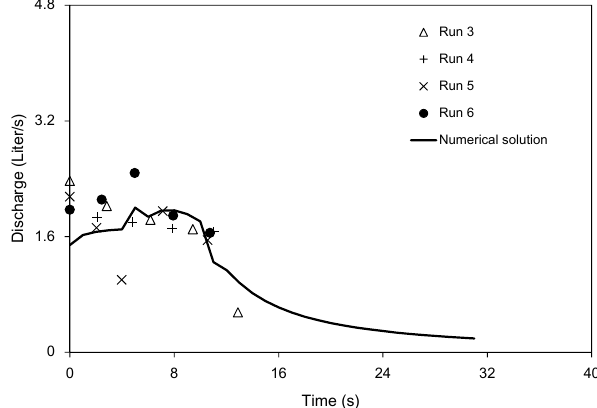
Figure 11. Comparison of discharge hydrographs at the down- stream end of the flume in Test 4.